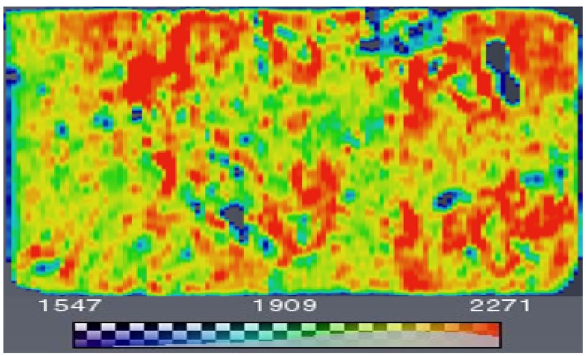
Fig. 7 CT scan image showing high level of heterogeneity and vugs along the length of